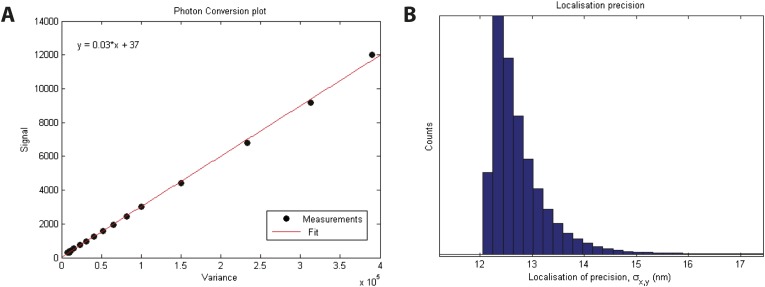
Localization precision.(A) Calibration of EMCCD camera for photon conversion factor. (B) Histogram of calculated localization precisions from dSTORM image data. The median value of localization precision (positional error) is 12 nm.